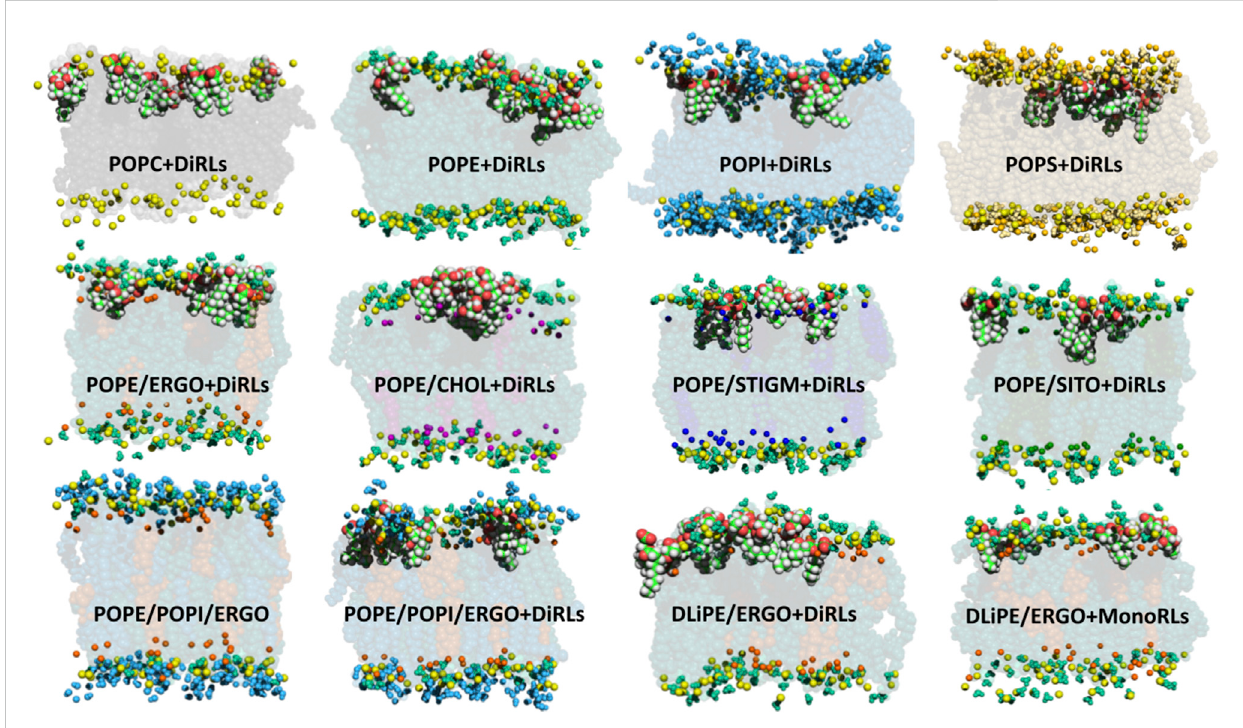
FIGURE 4 MD snapshots showing RLs internalised in several membranes with variable phospholipid compositions. Colour code: phosphorus atom (yellow); POPC body (black) and choline group (light grey); POPE body (dark green), headgroup (turquoise) and amine of the headgroup (light green); POPS body (brown), headgroup (gold), amine of the headgroup (light yellow) and carboxyl of the headgroup (orange); POPI body (blue), headgroup (light blue) and hydroxylsoftheheadgroup(cyan);CHOLbody(purple)andhydroxyl(lightpurple);ERGObody(darkorange)andhydroxyl(lightorange);SITObody (deep-dark green) and hydroxyl (pea-green); STIGM body (electric blue) and hydroxyl (light electric blue). For clarity, only functional groups of headgroupsarerepresented(spheres) intheupperlea fl et.RLsareshownasvanderWaalspheres(Cingreen,Hinwhite, Oinred).Binary modelscontain phospholipid:sterol mixtures at a molar ratio of